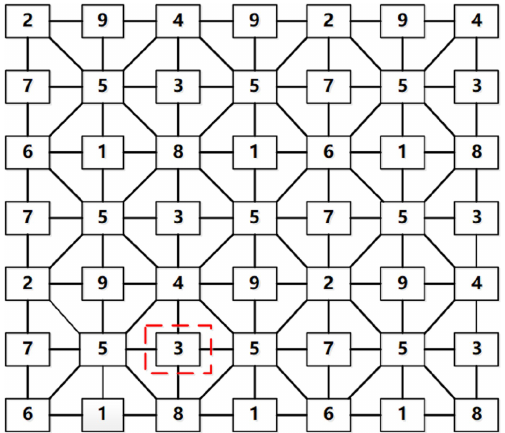
Figure 21. A visual reference topology diagram of nested 7 × 7 magic